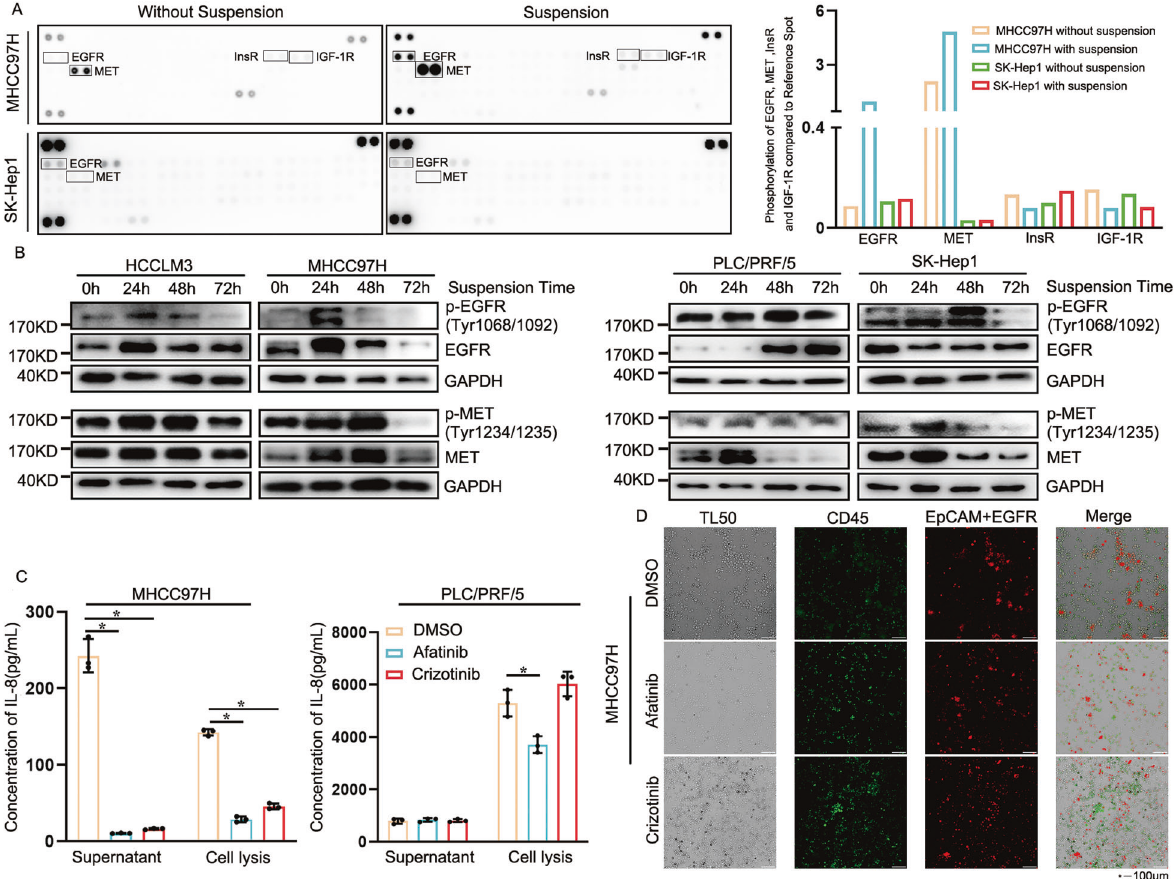
Fig. 3 Expression and phosphorylation of EGFR/MET was up-regulated in suspended HCC cells. A RTK array was used to measure phosphorylation of RTKs in suspended HCC cell lines. B Western blot was used to analyze phosphorylation of EGFR/MET in HCC cell lines with 0, 24, 48, 72 h of suspension. Low concentration of suspended HCC cells was used in prevention of cluster formation. C ELISA was used to detect IL-8 secretion of MHCC97H and PLC/PRF/5 cell lines with EGFR/MET inhibitor. D Immuno fl uorescence analyzed the interactions between MHCC97H cells and leukocyte with or without EGFR/MET inhibitor. Data are shown as the mean ± SD, n = 3. * P < decreased and the G1-phase of the cell cycle increased in HCC with or without suspension. Moreover, S-phase increased in suspended HCC cells, indicating that the Ras/MAPK pathway maintained the growth of HCC cell lines (Fig. 5B, C). Flow cytometry con fi rmed that inhibition of the Ras/MAPK pathway in HCC cells with or without suspension could promote the increase of apoptosis in HCC cell lines, but the effect in HCC cells with suspension was signi fi cant (Fig. 5D). We also found all cyclin proteins were down-regulated followed by Ras/MAPK inhibition. In detail, Cyclin A/B were less interfered with by Ras/ MAPK inhibitors and poorly expressed in suspended HCC cell lines. Conversely, Cyclin E was highly expressed in suspended HCC cell lines and could be easily down-regulated by Ras/MAPK inhibitors. Both cultured in suspension and Ras/MAPK inhibitors could activate PARP, a protein major in DNA repairing in HCC cell lines [22]. Moreover, a combination of Ras/MAPK inhibitor and suspension caused higher activation of PARP in HCC cell lines, which was related to higher apoptosis of HCC cell lines (Fig. 5E). Also, inhibition of the Ras/MAPK pathway made suspended HCC cells more easily to be killed by leukocytes (Fig. 5F). Collectively, the data indicated that the Ras/MAPK pathway induced by EGFR/MET stabilized suspended HCC cell lines and prevented the lethal effect of leukocytes. Moreover, it was more dif fi cult for suspended HCC cells to survive under a condition of poorly phosphorylated ERK.